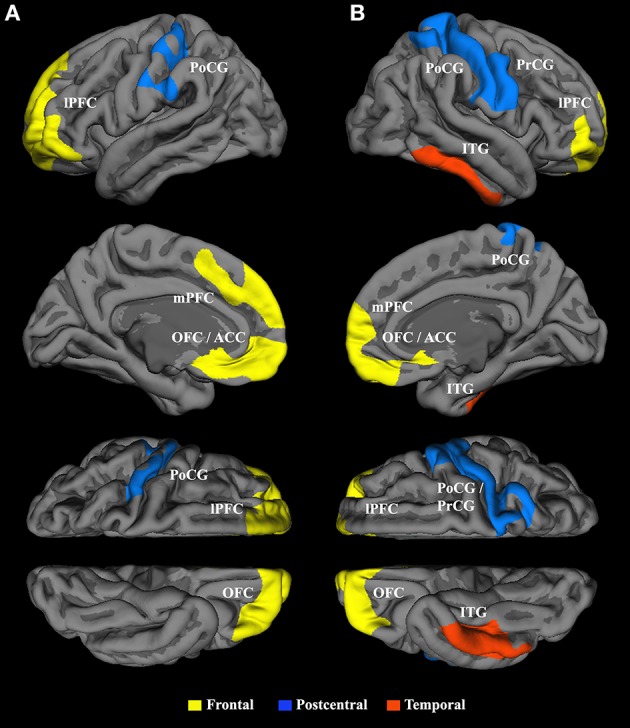
Inverse correlation between cortical surface area and Rivermead Post-Concussion Symptoms Questionnaire scores in the patient group (n = 51). Panels of the top row show the lateral hemispheres (A = left, B = right), whereas the second row shows the medial hemispheres. The third and bottom rows represent the superior and inferior views, respectively. Bilateral frontal clusters (yellow) encompass the lateral and medial prefrontal cortex, the orbitofrontal cortex and the anterior cingulate cortex. The parietal cluster (blue) in the left hemisphere includes the postcentral gyrus (PoCG) together with parts of the central sulcus, while the frontoparietal cluster (blue) in the right hemisphere stretched over the PoCG and the precentral gyrus. The red cluster in the right hemisphere comprises the inferior temporal gyrus. Only clusters exceeding a cluster-wise corrected probability of p < 0.05 are shown.